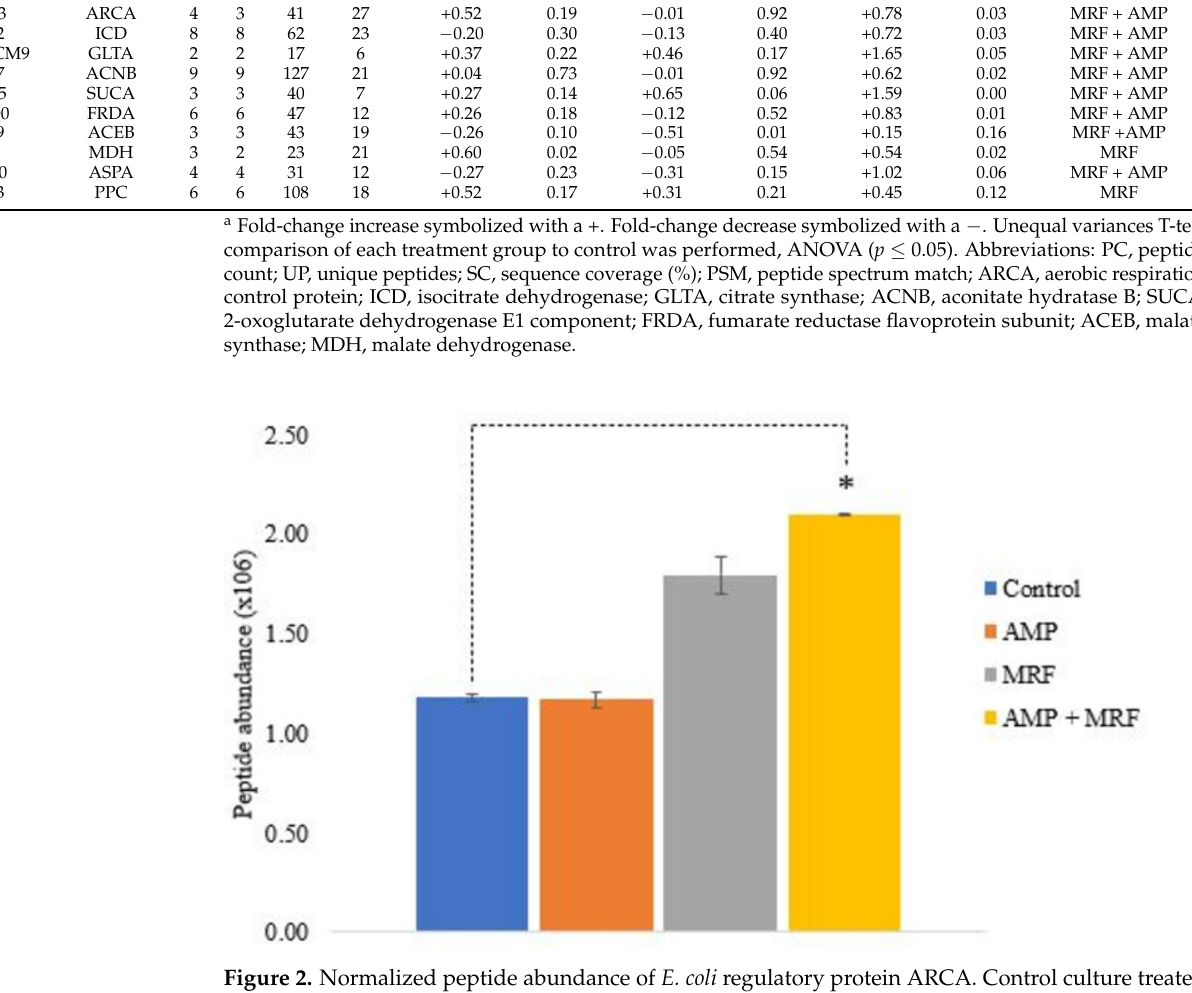
Figure 2. Normalized peptide abundance of E. coli regulatory protein ARCA. Control culture treated with AMP (0.1 mgmL − 1 AMP), MRF (1 mgmL − 1 ), or a combination of AMP (0.1 mgmL − 1 ) + MRF (1